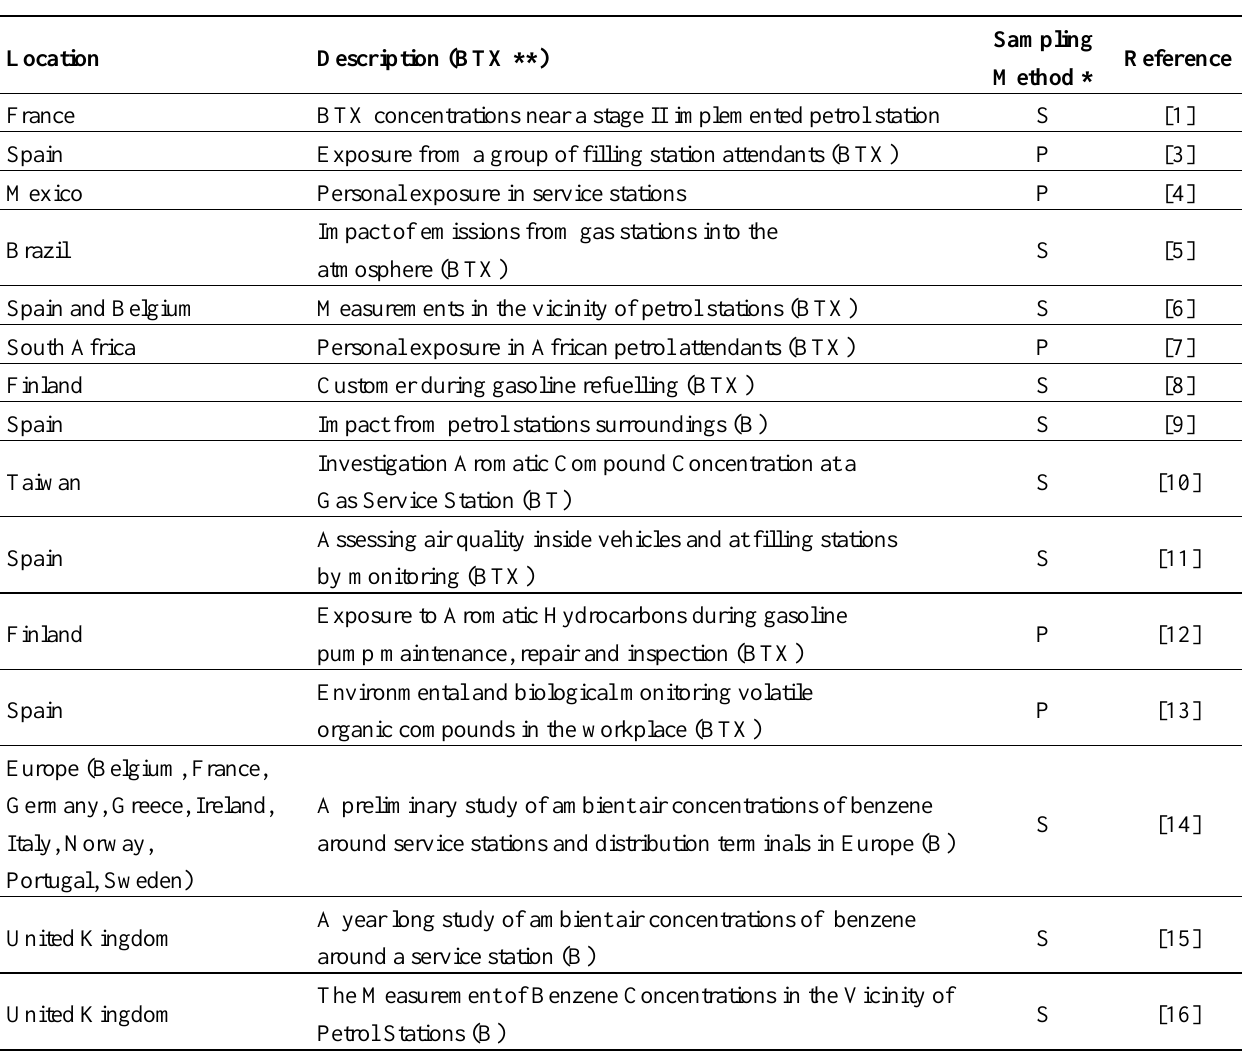
Table 1. Investigations of concentrations reported as individual values of BTX in service station